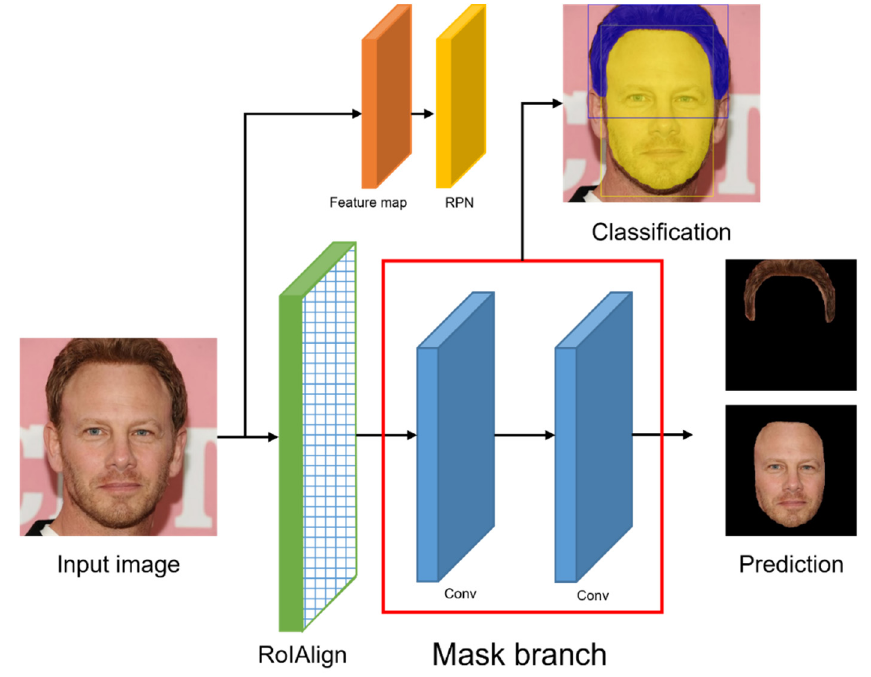
Figure 2. Basic framework of Mask R-CNN.